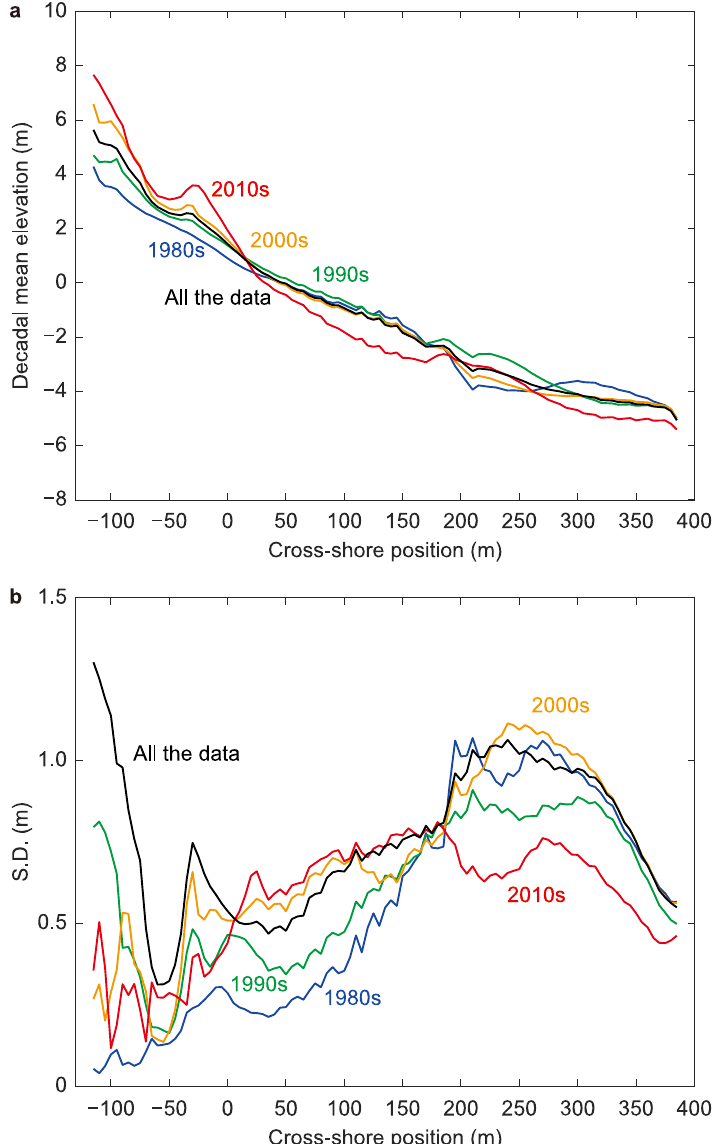
Figure 6. Decadal mean profile and the standard deviation. ( a ) Decadal mean profiles from the 1980s to the 2010s with the mean profile for all the data; ( b ) standard deviations of the elevations for each decade with that for all the data.